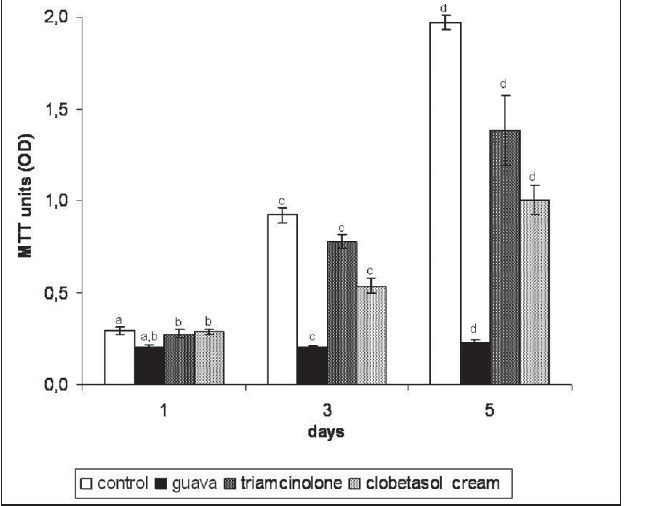
Fig. 1. Cell viability (MTT assay) in the four experimental groups. Same letters indicate statistically significant difference among groups.